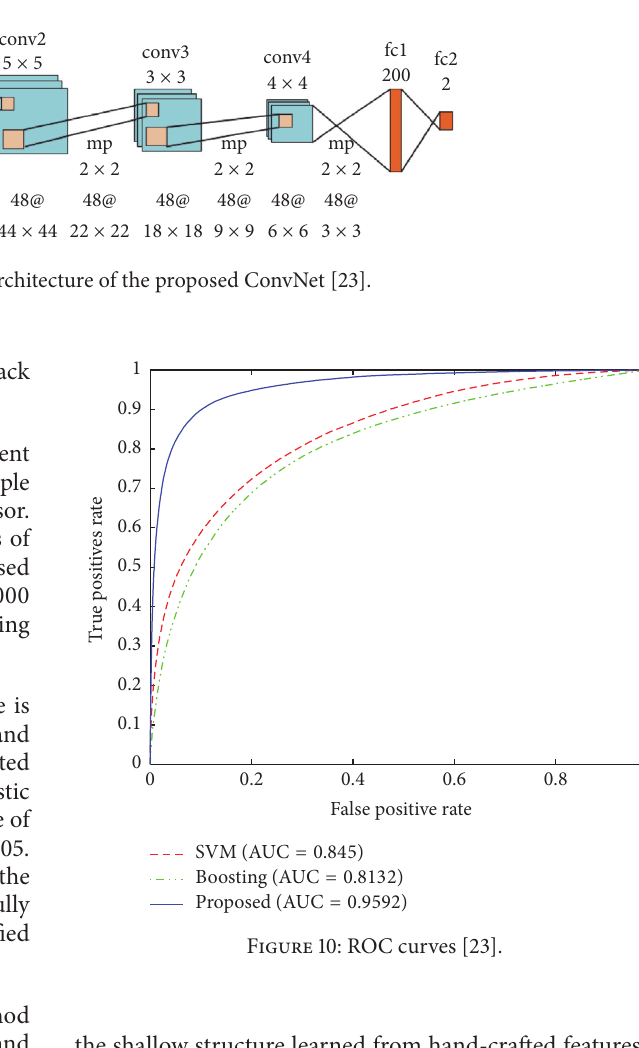
Figure 8: Outline of DeepFace architecture [66].